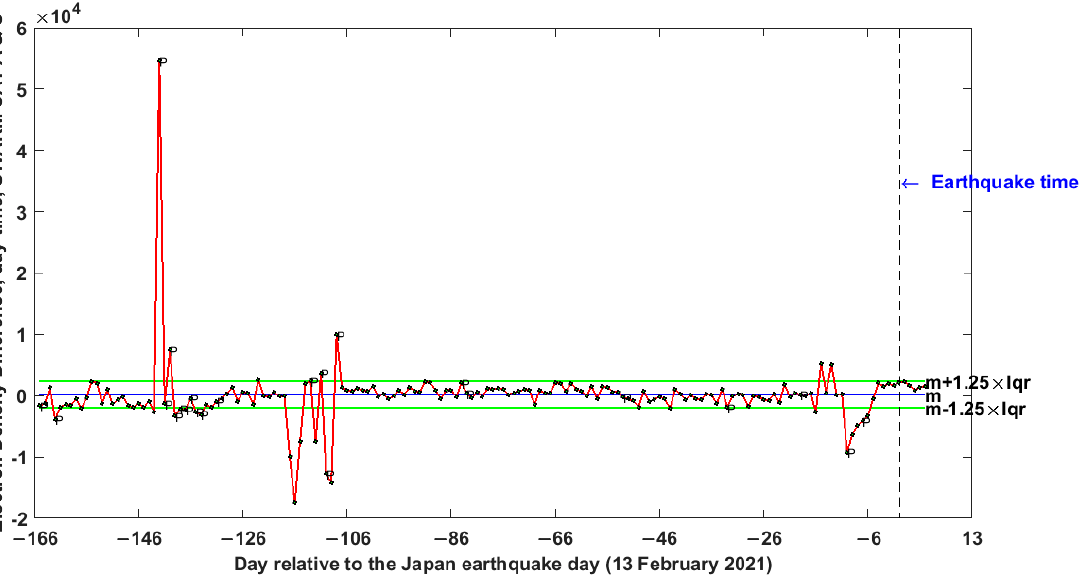
Figure 6. Results of Swarm A and C electron density differences for the Japan earthquake (13 February 2021) from 1 September 2020 to 18 February 2021 during the day-time. The geomagnetically “perturbed” days are highlighted by a “P”.